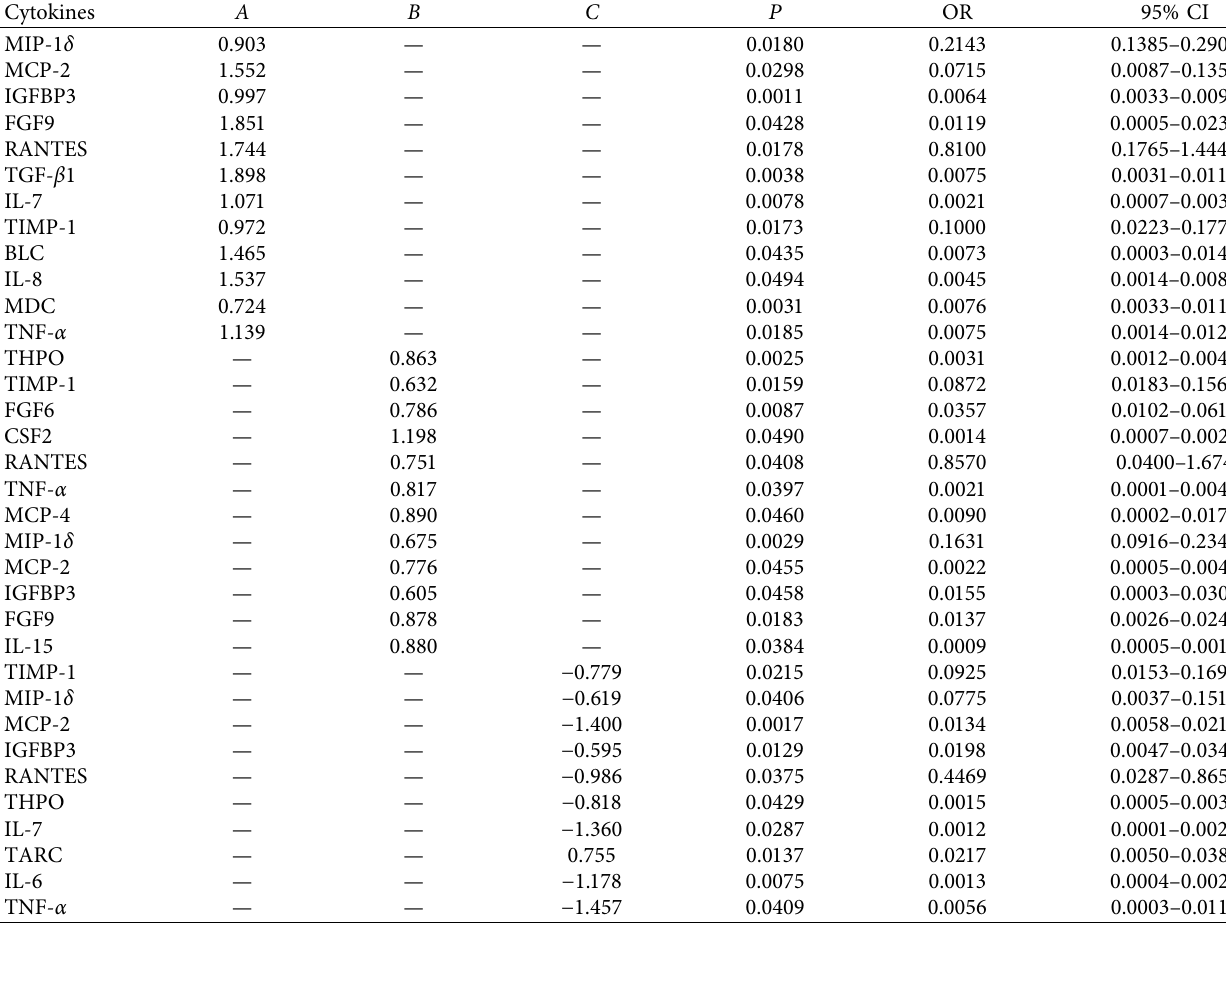
Table 3: Comparative analysis between groups of